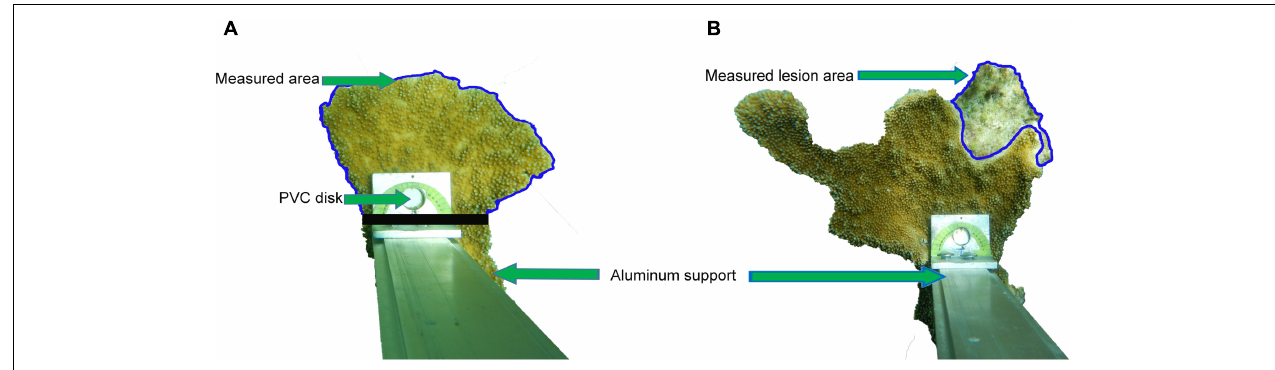
FIGURE 2 | The technique for the measurement of surface growth rates of Acropora palmata branches is shown. A camera was attached to an aluminum support that was fixed to a PVC disk. The blue outline indicates the area measured in an apparently healthy colony (A) and in (B) the blue outline indicates the measured area of a lesion in a colony with old partial mortality. The measured area of healthy tissue in colonies with old partial mortality were measured as in (A) .